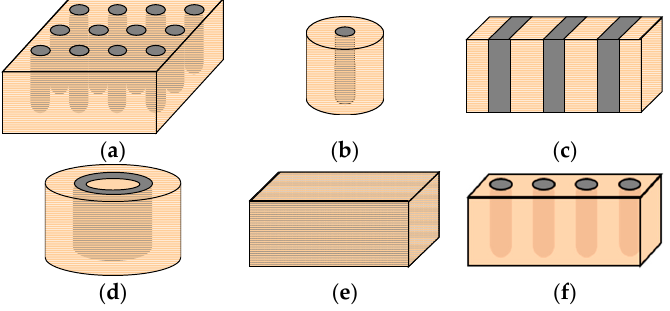
Figure 1. Main geometrical models for stone column studies: ( a ) Full 3D model; ( b ) Unit cell; ( c ) Longitudinal gravel trenches; ( d ) Cylindrical gravel rings; ( e ) Equivalent homogenous soil; ( f ) 3D slice of columns.